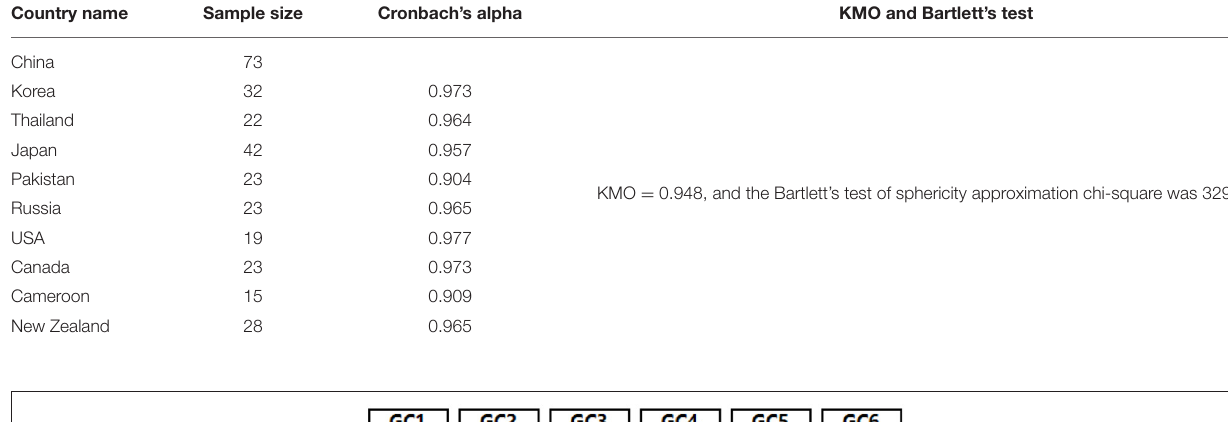
TABLE 3 | Validity and reliability tests of countries.